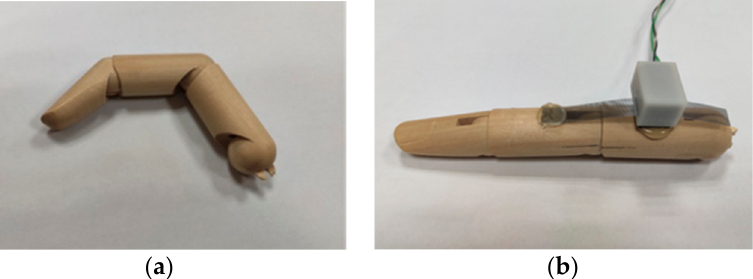
Figure 10. Response testing device. ( a ) Wooden finger; ( b ) Wooden finger with a sensing unit.